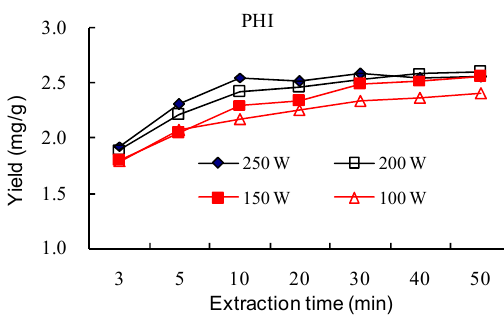
Figure 7. Effect of ultrasonic input power and extraction time on the extraction yields of forsythiaside A (FSA), rutin (RT) and phillyrin (PHI).